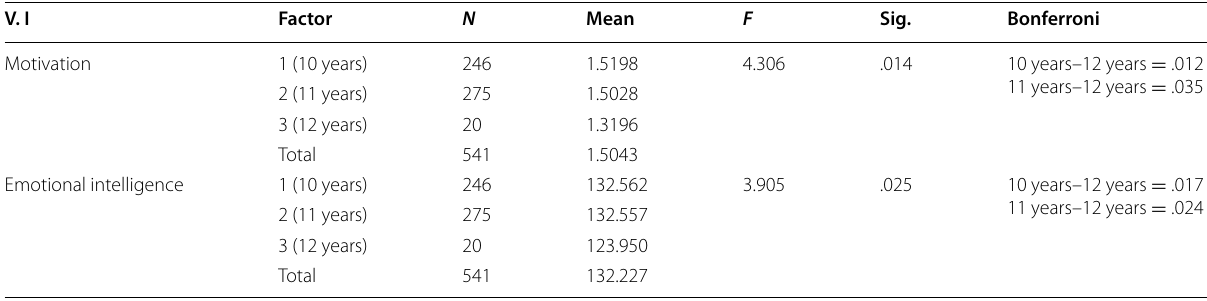
Table 5 Results of ANOVA between the different age groups and the Bonferroni post hoc test for school motivation and EI V.